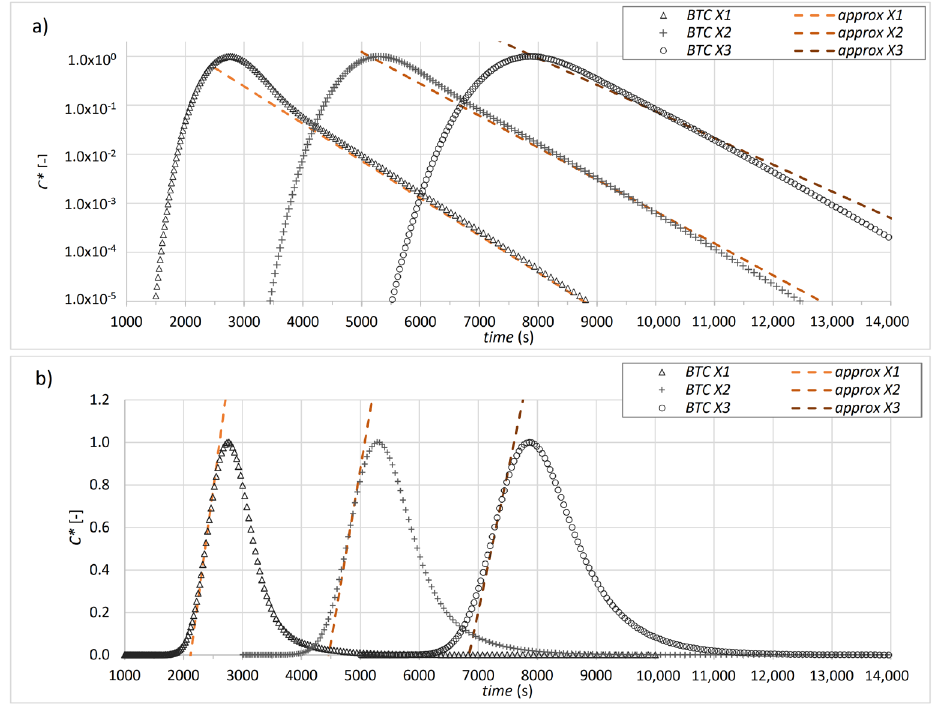
m, m and m and 𝑋𝑋 1 = 500 𝑋𝑋 2 = 1000 𝑋𝑋 3 = 1500 are used for the concentration curves in Figure 2, at each section used for normalizing the